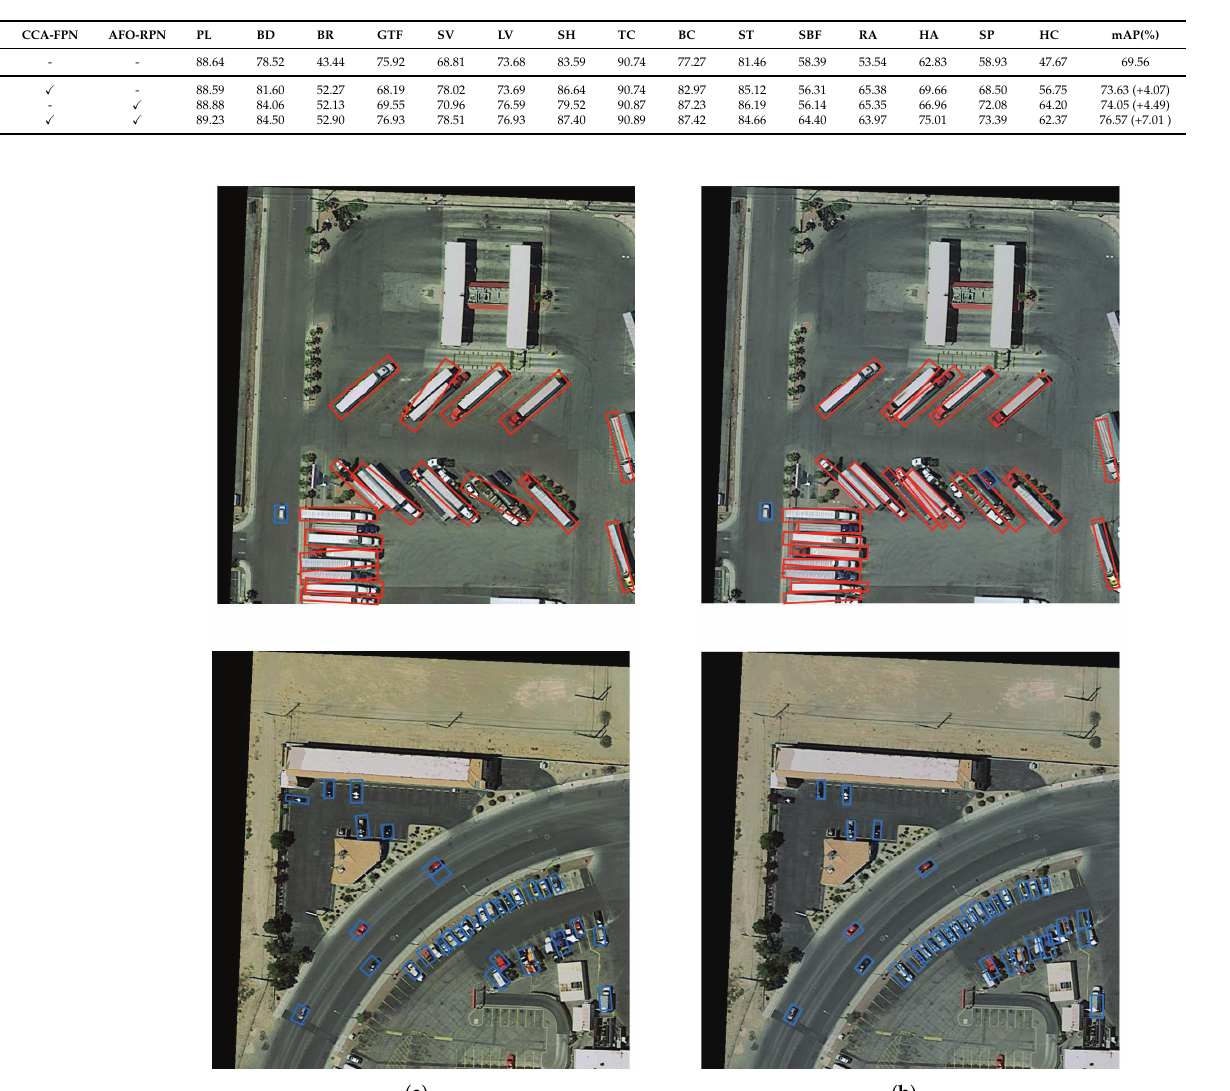
Table 4. Ablation study of proposed modules on DOTA dataset test set.